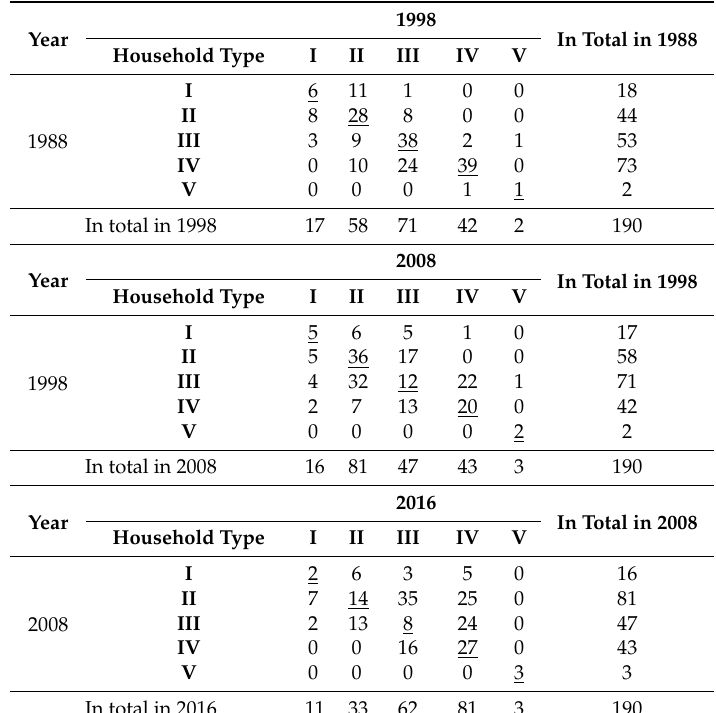
Table 8. Matrix showing changes in household